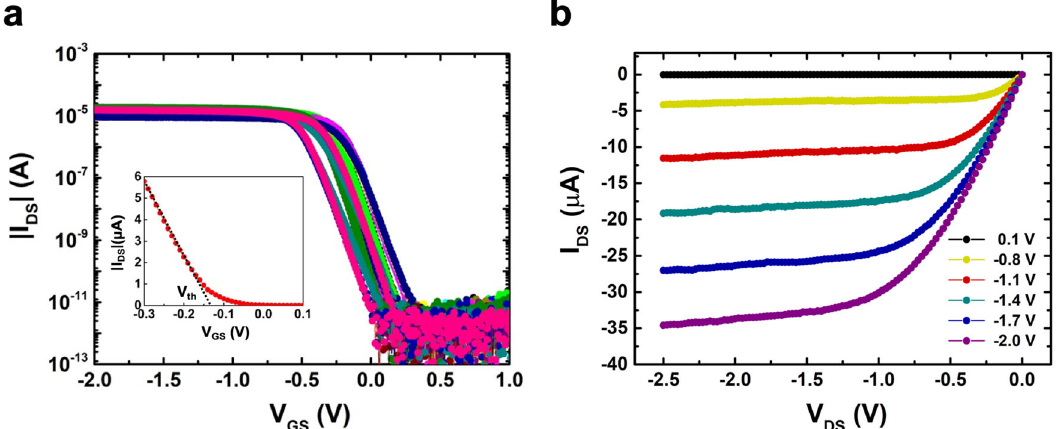
Fig. 2 Electrical characteristics of the Si FinFET. a Measured transfer characteristics of the 12 Si FinFETs spread on the same wafer ( V DS = − 1 V). The inset shows a linear fi tting line to the transfer characteristic to estimate the threshold voltage ( V th ). b Measured output characteristic of a FinFET at applied V GS = 0.1 V to − 2